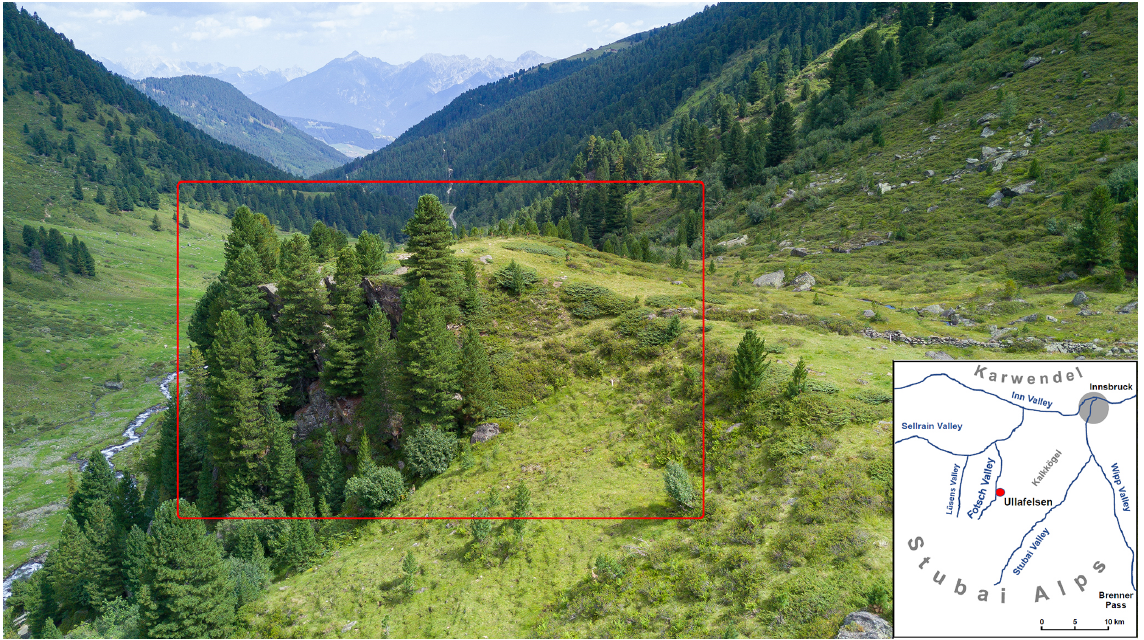
Figure 1. The prehistorical encampment site of Ullafelsen in the Fotsch Valley, Stubai Alps, southwest of Innsbruck, Tyrol, Austria. North- ward view from the inner Fotsch Valley over the Ullafelsen (1869ma.s.l.) to the Karwendel mountain range in the Northern Limestone Alps (photo: Eike Hüsing,